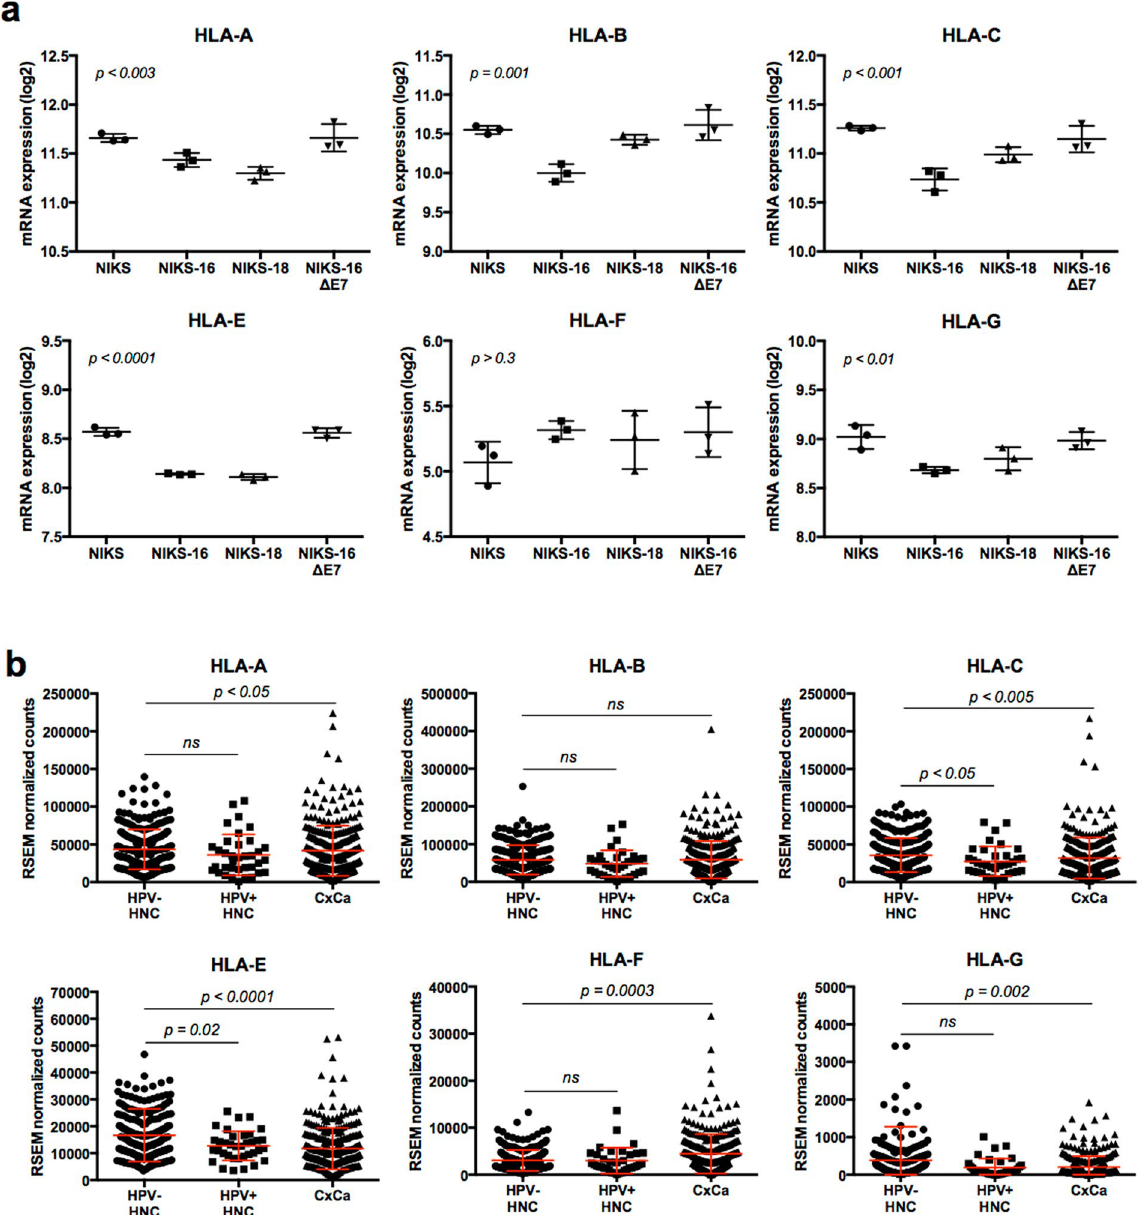
Figure 2. MHC-I gene expression is downregulated in HPV-positive keratinocytes and cancers in an E7- dependent manner. ( a ) Normalized gene expression of HLA-A, -B, -C, -E, -F , and -G in triplicated NIKS (circle), NIKS-16 (square), NIKS-18 (triangle), and NIKS-16 Δ E7 (inverse triangle) cells is shown. Fluorescence intensity (log 2 ) of each replicate is plotted with p -values calculated by one-way ANOVA test. ( b ) The RNA-seq RSEM (RNA-seq by expectation maximization) counts of HLA-A, -B, -C, -E, -F , and -G were obtained from the TCGA data through cBioPortal (cbioportal.org): HPV-negative HNC, n = 243; HPV-positive HNC, n = 36; CxCa, n = 309 (NCI, TCGA, Provisional). Normalized RSEM counts are shown in scatter plots with mean and standard deviation. P -values were determined by Mann-Whitney test. n . s ., not